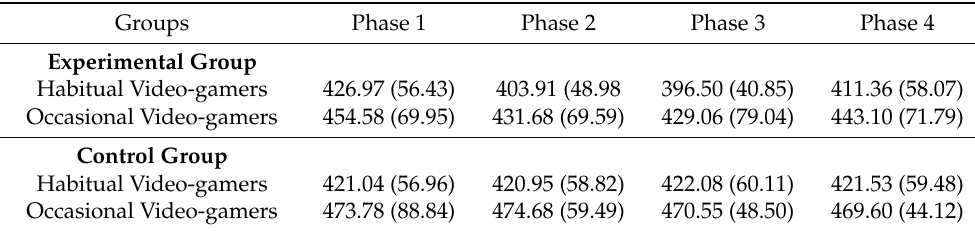
Table A4. Means (and standard deviations) of the RTs in the Go/No Go Visual Research